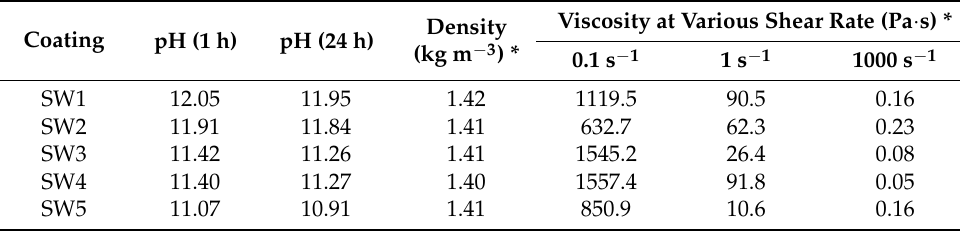
Table 3. pH, density, and viscosity at different shear rate of the